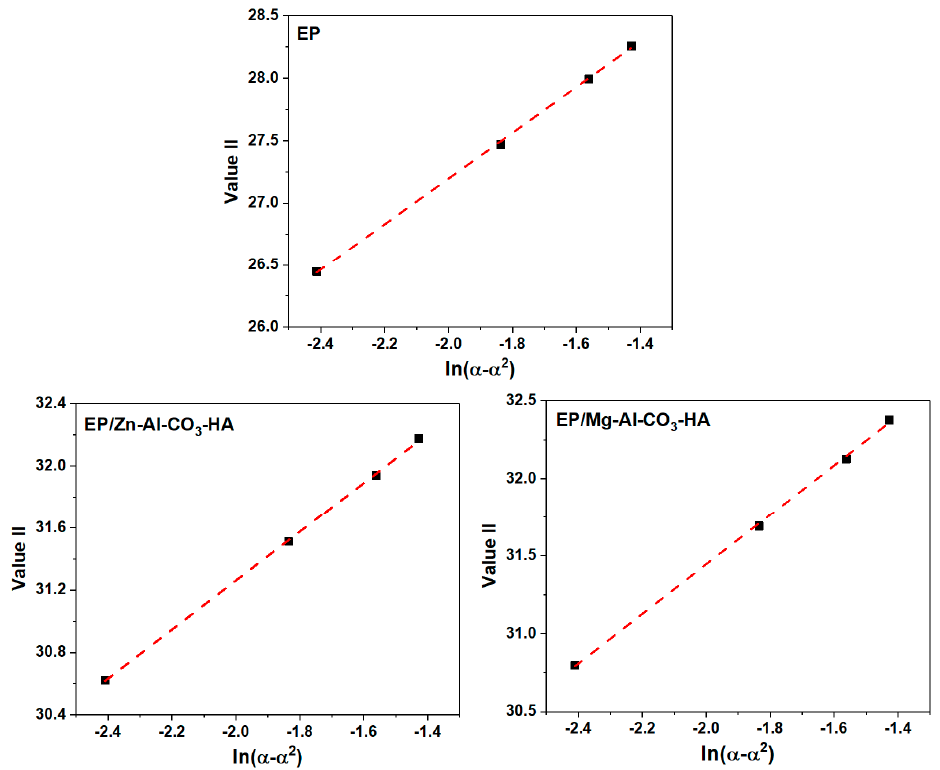
Figure C1. Plots of Value I for the prepared samples. Figure A6. Plots of Value I for the prepared samples. Polymers 2020 , 12 , x FOR PEER REVIEW